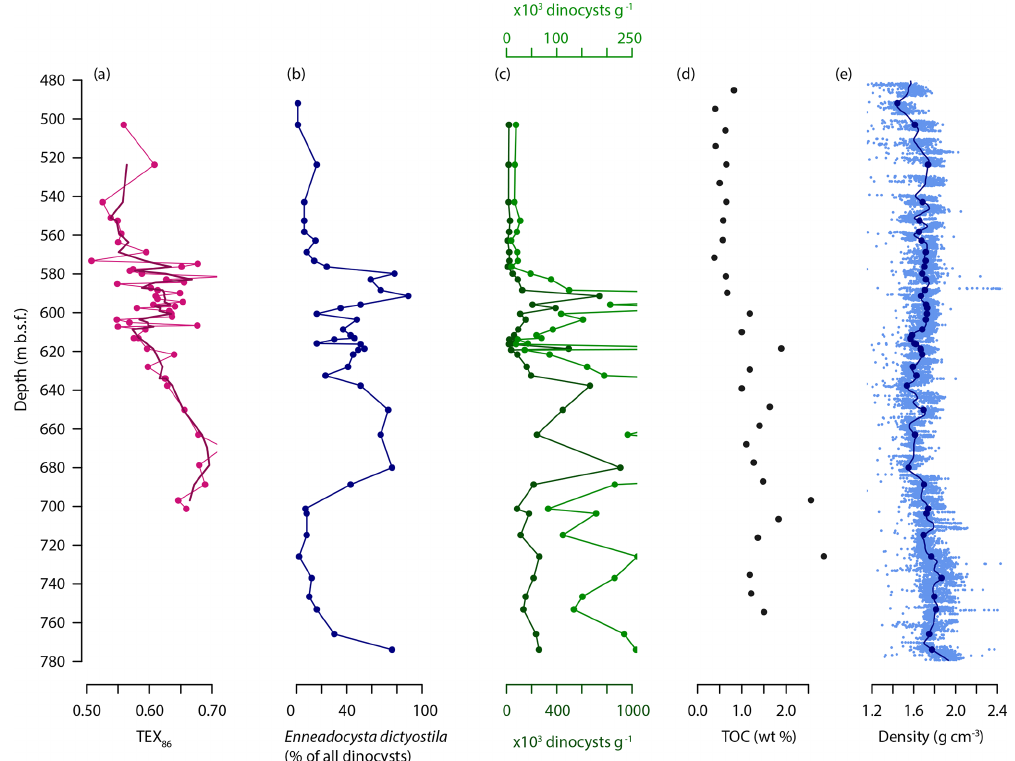
Figure 6. Selected proxy records over the MECO interval of Site 1170, plotted against depth in meters below sea level (mb . s . l . ). (a) TEX 86 (pink dots and line), with three-point moving average (purple lines). (b) Relative abundance of Enneadocysta dictyostila (percentage of total dinocyst assemblage; dark blue dots and line). (c) Dinoflagellate cyst content (cysts per gram of dry sediment; two different scales shown for visual clarity in dark green and light green). (d) Total organic carbon (weight percentage; black dots) (from Exon et al., 2001). (e) Gamma ray attenuation (GRA) sediment density (in gcm − 3 ; light blue dots original data; dark blue line LOESS fit; dark blue dots interpolated LOESS fit to depth of dinocyst samples) (from Exon et al.,